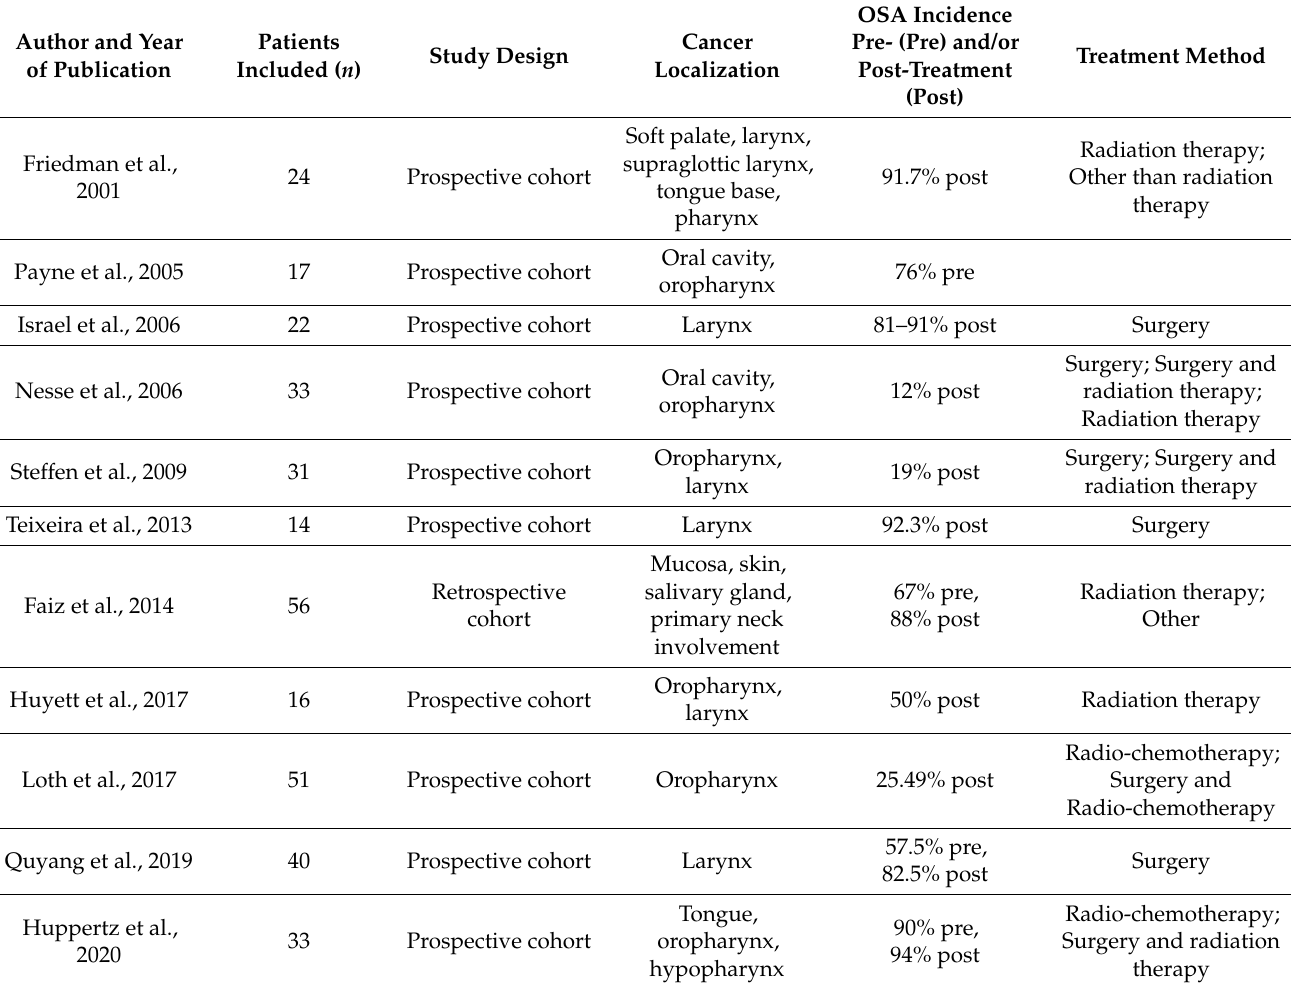
Table 1. Studies on the comorbidity of obstructive sleep apnea and head and neck